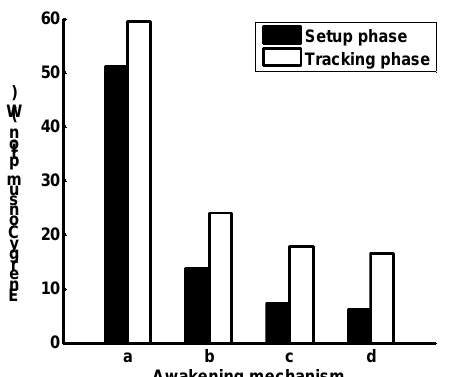
Figure 6. Comparison of energy consumption in setup and tracking phase with different awakening mechanisms.